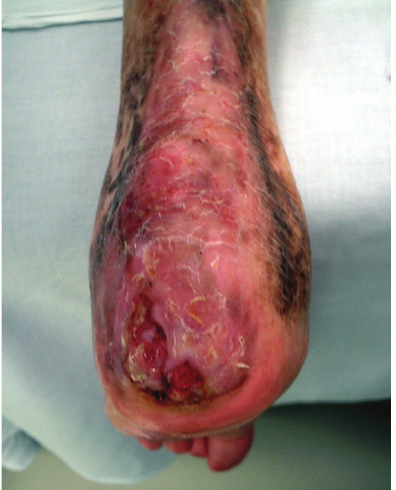
Figure 1: Chronic ulcer and exposed calcaneal cortex bone over the posterior aspect of the left heel.